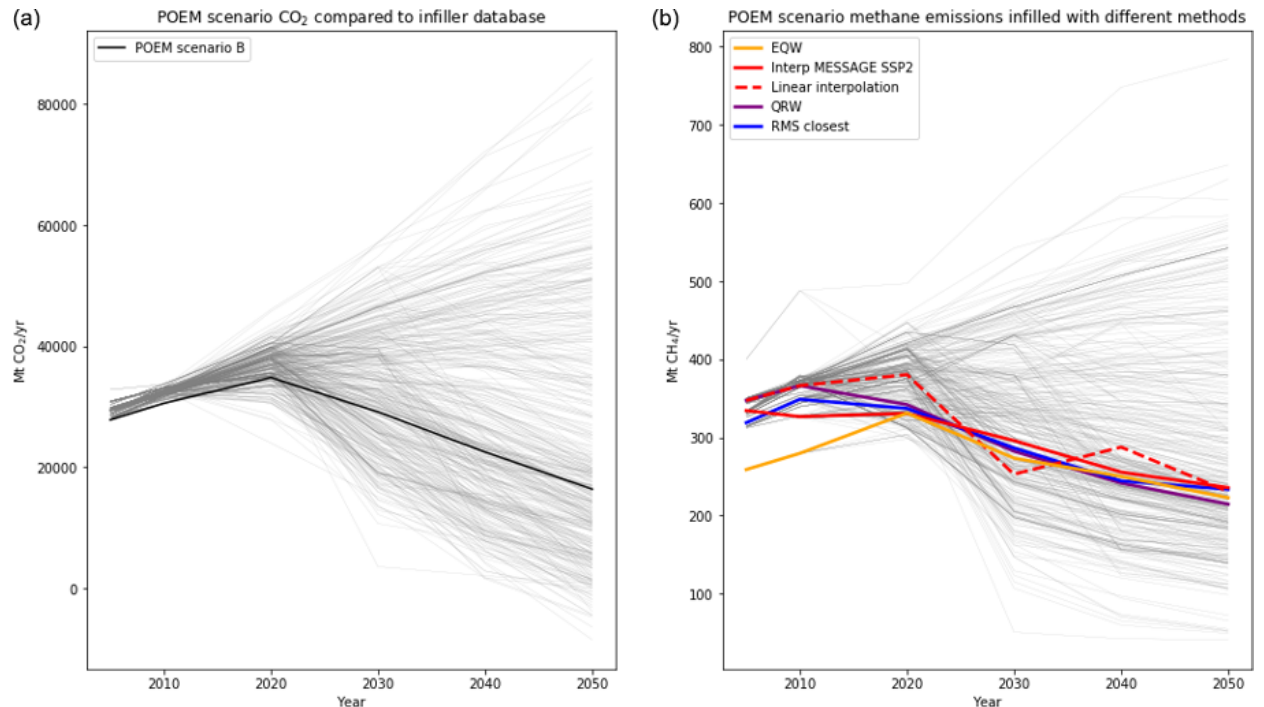
Figure 3. (a) The POEM scenario B projection for CO 2 from energy and industrial applications data. The fine lines represent the different time series in the SR1.5 database used to perform the infilling and are not included in the legend for clarity. (b) The results of interpolating these data using five different crunchers. The “interpolate specified model” approach used the MESSAGE model and only chose scenarios based on